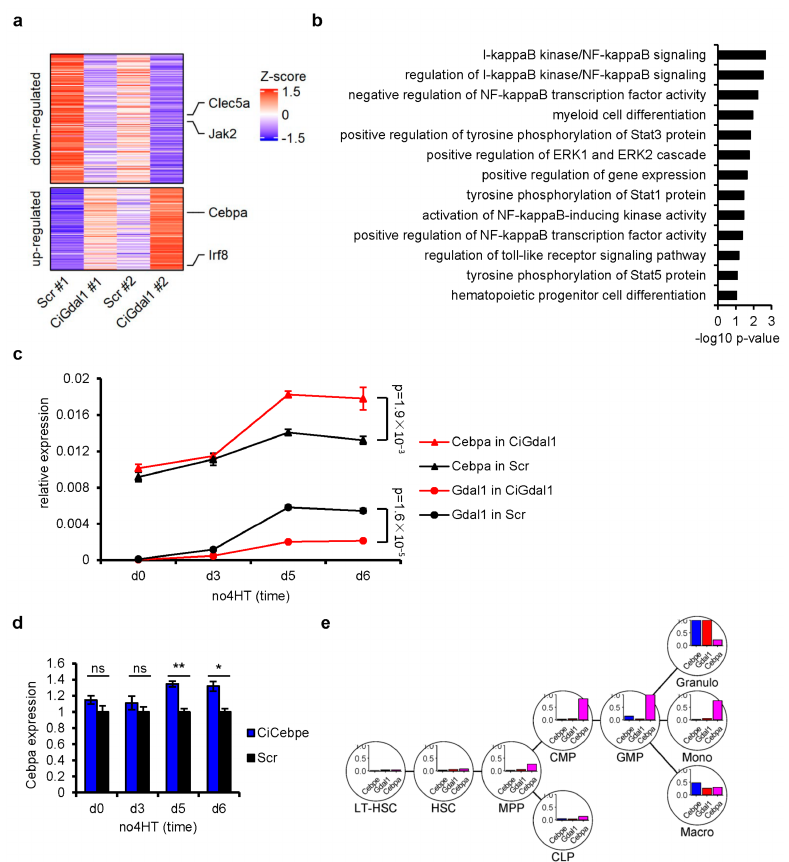
Figure 4. Transcriptome analysis in Gdal1 knockdown CSH3 cells further confirmed the involvement of Gdal1 in myeloid differentiation. ( a ) Genes influenced in Gdal1 knockdown CSH3 cells with differentiation blockage. The heat map shows the expression level of 372 genes based on transcrip- tome sequencing in two pairs of knockdown/control cells. Up-panel shows down-regulated genes in Gdal1 knockdown cells, and low-panel shows up-regulated genes in Gdal1 knockdown cells. Marked genes are related to myeloid differentiation. ( b ) GO term enrichment analysis of influenced genes in Gdal1 knockdown cells. Biological process GO terms related to myeloid differentiation and its regulation were shown. ( c ) The expression of Cebpa was up-regulated in Gdal1 knockdown CSH3 cells with differentiation blockage. Relative expressions of genes were analyzed by qPCR in Gdal1 knockdown and control differentiating CSH3 cells. 2 − ∆ Ct is used to data normalization. ( d ) The expression of Cebpa was also up-regulated in Cebpe knockdown CSH3 cells. RNA level of Cebpa was analyzed by qPCR. The expression of Cebpa increased significantly on the 5th and 6th day after the initiation of differentiation. ( e ) Gene expression patterns of Cebpe , Gdal1, and Cebpa during myeloid differentiation in BloodSpot database. Gene expression levels of each gene normalized to its maximal value in these cell types are shown. Ci stands for CRISPRi. Gene expression data by qPCR is represented as mean ± SEM of 3 replicates. ns p > 0.05, * p ≤ 0.05, ** p ≤